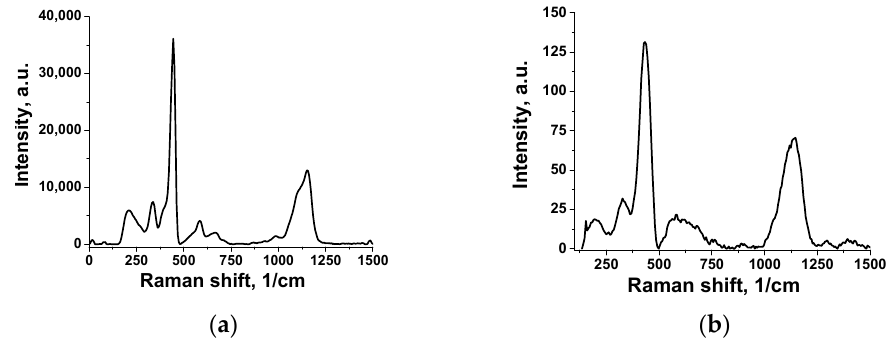
Figure 6. Raman spectrum of the ZnO film deposited on: ( a ) Al layer; ( b ) Cu layer.